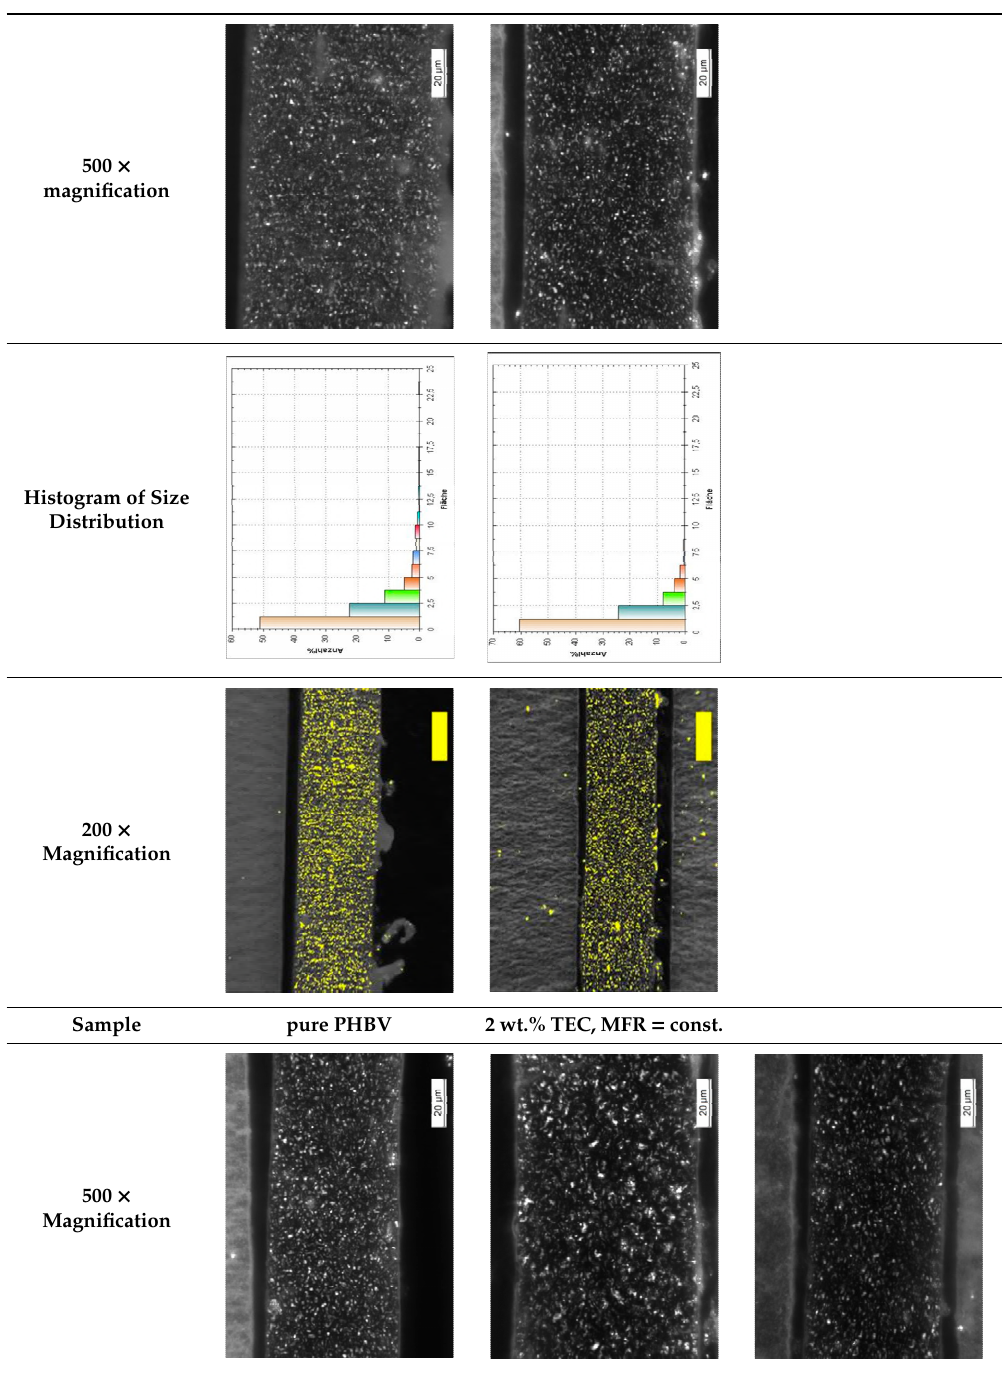
Table 5. Polarisation microscopy measurements at surfaces of PHBV film blended triethyl citrate (TEC), constant melt flow rate (MFR) during extrusion. “Anzahl”: amount; “Fläche”: area.